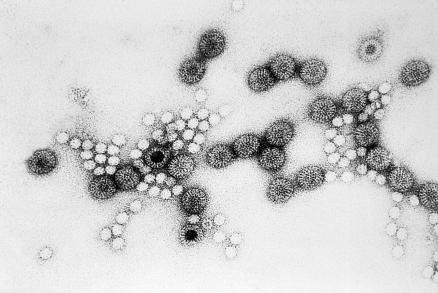
Electron micrograph showing a number of RNA rotavirus virions (which have a wheel-like appearance) and a number of unknown, 29 nm virion particles